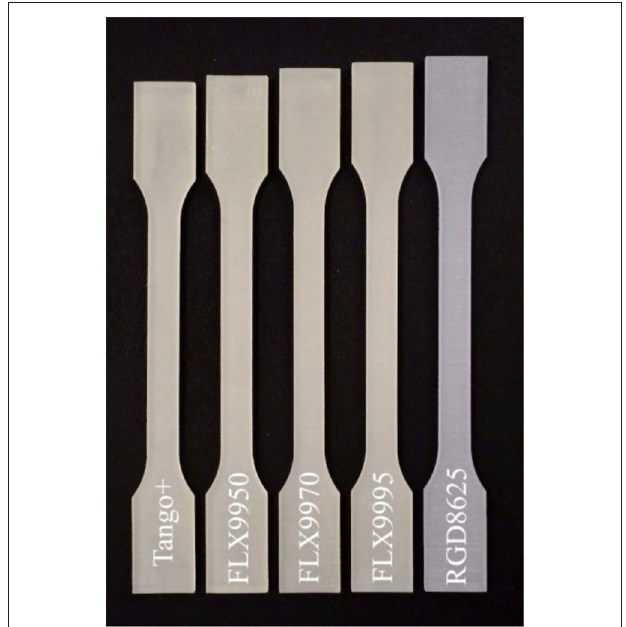
FIGURE 9 | Illustration of the material shrinkage of ZX-oriented tensile specimens, manufactured from different digital materials (combination of Tango + and VeroClear). The rigid material RGD8625 shows the lowest deviation ( + 0.11mm on average) from the nominal length (l3 = 175